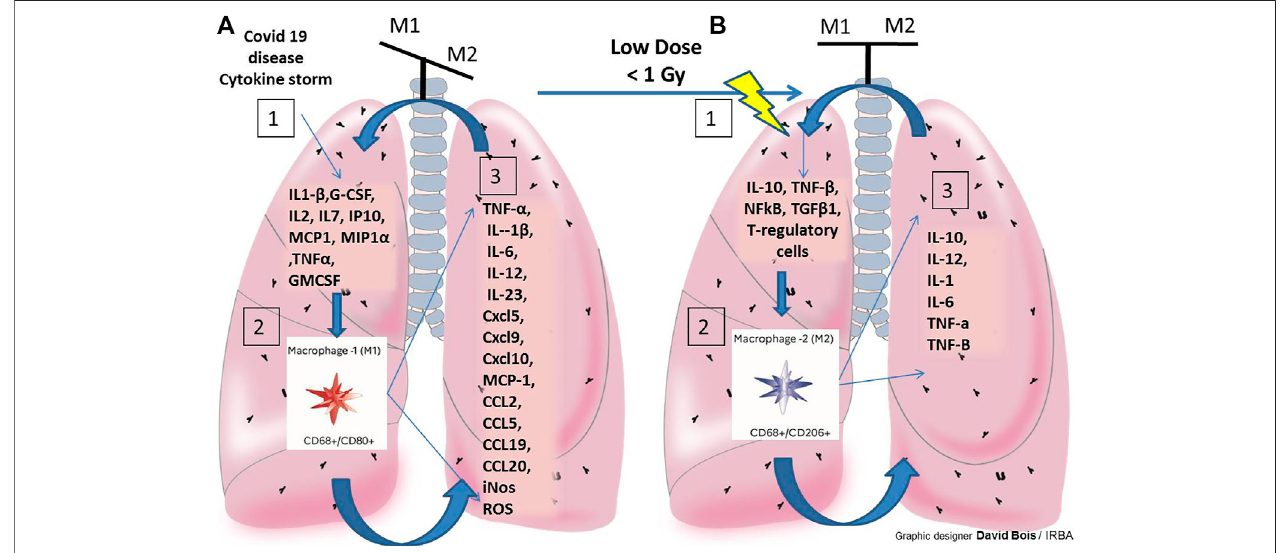
FIGURE 3 | Bene fi cial effect of low-dose irradiation to reprogram macrophages in anti-in fl ammatory M2 promoting tissue repair or slowing the progression of severelungdamageinducedbycovid19disease.BalanceofM1/M2macrophageisnecessarytoachievepropertissuerepair.Hyperin fl ammationandtheseverityofthe lesions alter this balance (illustrated above each of the lungs A and B ). (A) : Illustrations and details of M1 macrophage stimulation in COVID19 in the lung and their pro- in fl ammatory potential with very little macrophage reprogramming into anti-in fl ammatory M2. Depending on severity and duration in fl ammation (M1 persistent activation) this leads to severe lung damage by covid 19 disease. (B) : To generate an anti-in fl ammatory environment: stimulate the polarization of the M2 macrophages with low dose radiotherapy (RT). Macrophages also switch to an anti-in fl ammatory (M2) phenotype, leading to a wound healing phase: Maintains M1/M2 balance or slowingtheprogressionoflungdamageinducedbycovid19disease.1/2/3representthe3stepsgeneratedincaseA,anM1macrophagephenotypewithinthelungsof covid19patients,incaseB,step1(effectsoflowdosesofRTinlung,with a NO,ROS, a leukocytes/endothelialcellsadhesionand b IL-10,TNF- β ,NFkB,TGF1,AP-1 et T-regulatory cells), step 2 (stimulation of the polarization of M2 macrophages in this environment post-low dose RT) and step 3: the secretion products of M2 promoting an anti-in fl ammatory